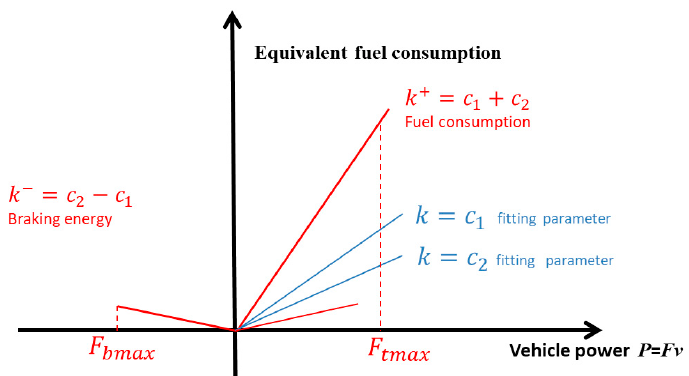
Figure 2. Equivalent fuel consumption (EFC) with both traction and brake control.